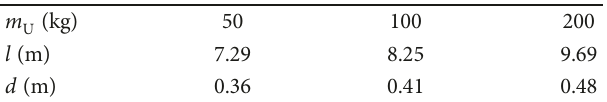
Table 5: Optimal con fi gurations for each payload mass, Δ T 10 min.